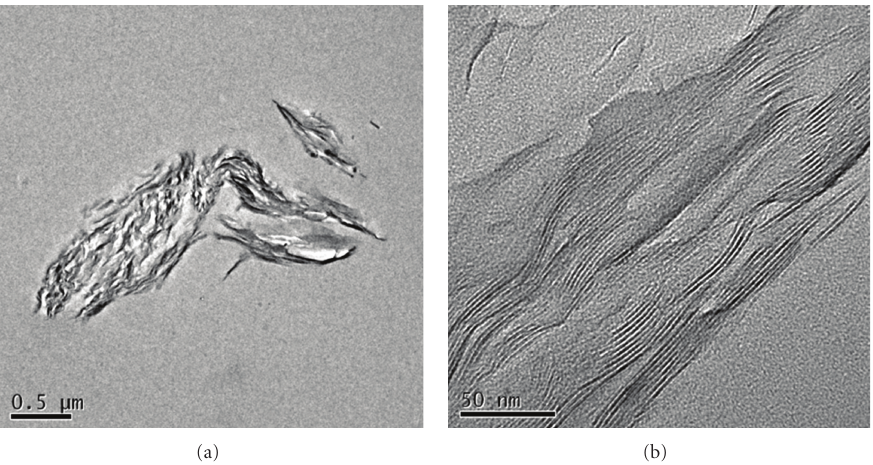
Figure 10: TEM images of epoxy/clay nanocomposites via normal mixing method at di ff erent magnifications.